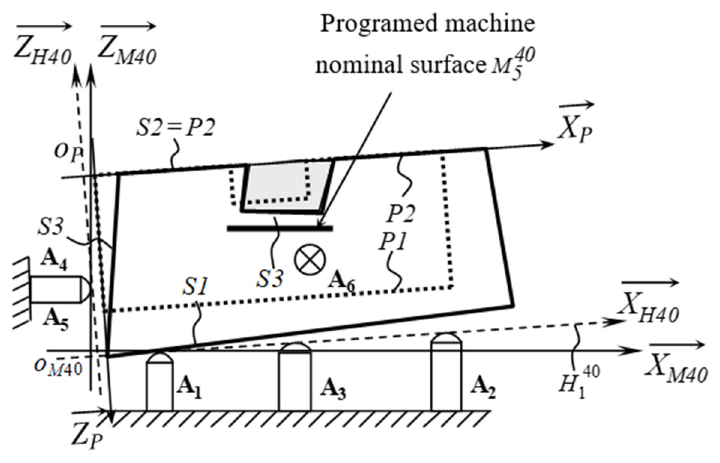
Figure 9. Positioning of the part in the phase 40.